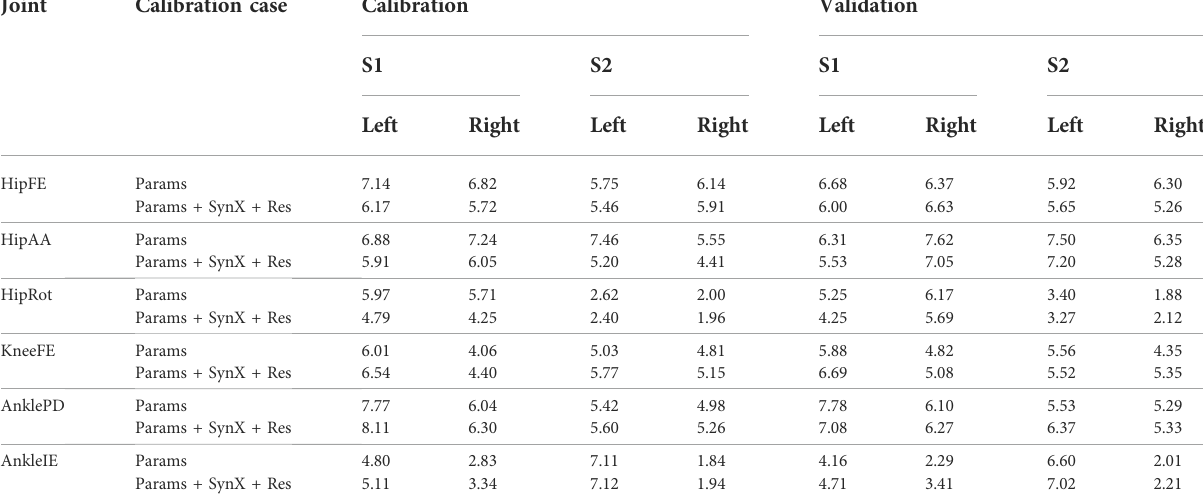
TABLE 4 Mean absolute error (MAE) values calculated between joint moments found from inverse dynamics and either “ Params ” calibration or “ Params + SynX + Res ” calibration. Joint Calibration case Calibration Validation S1